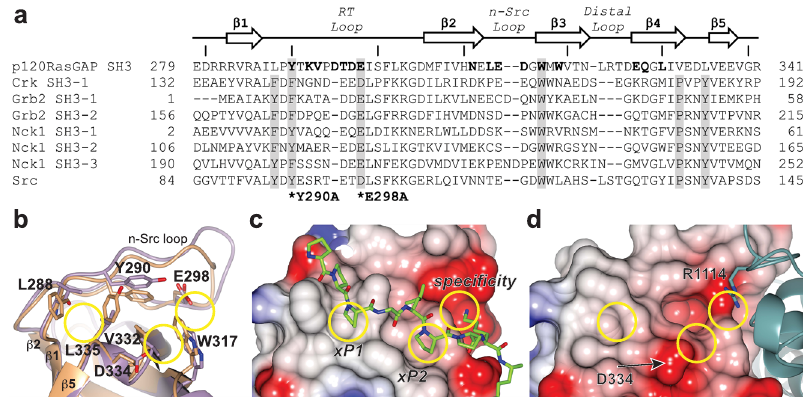
Fig. 6 | p120RasGAP harbors an unusual SH3 domain. a Structure-based sequencealignment(Daliserver)ofSH3domainofp120RasGAPwithSH3domains of human Crk (Uniprot ID: P46108), Grb2 (Uniprot ID: P62993), Nck1 (Uniprot ID: P16333) and Src (Uniprot ID: P12931). SH3-1, -2 or -3 indicates the speci fi c SH3 domainwithinaproteincontainingmultipleSH3domains.Residuesinp120RasGAP thatinteractwiththeRhoGAPofDLC1arehighlightedinbold.Residuesincanonical SH3 domains that form the conserved xP binding pockets (xP1 and xP2) and spe- ci fi citypocket are shaded in gray. Positions ofresidues mutated in thisstudy - Tyr- 290andGlu-298-aremarked(*)andlabeled.Inapreviousstudy,onlyp120RasGAP